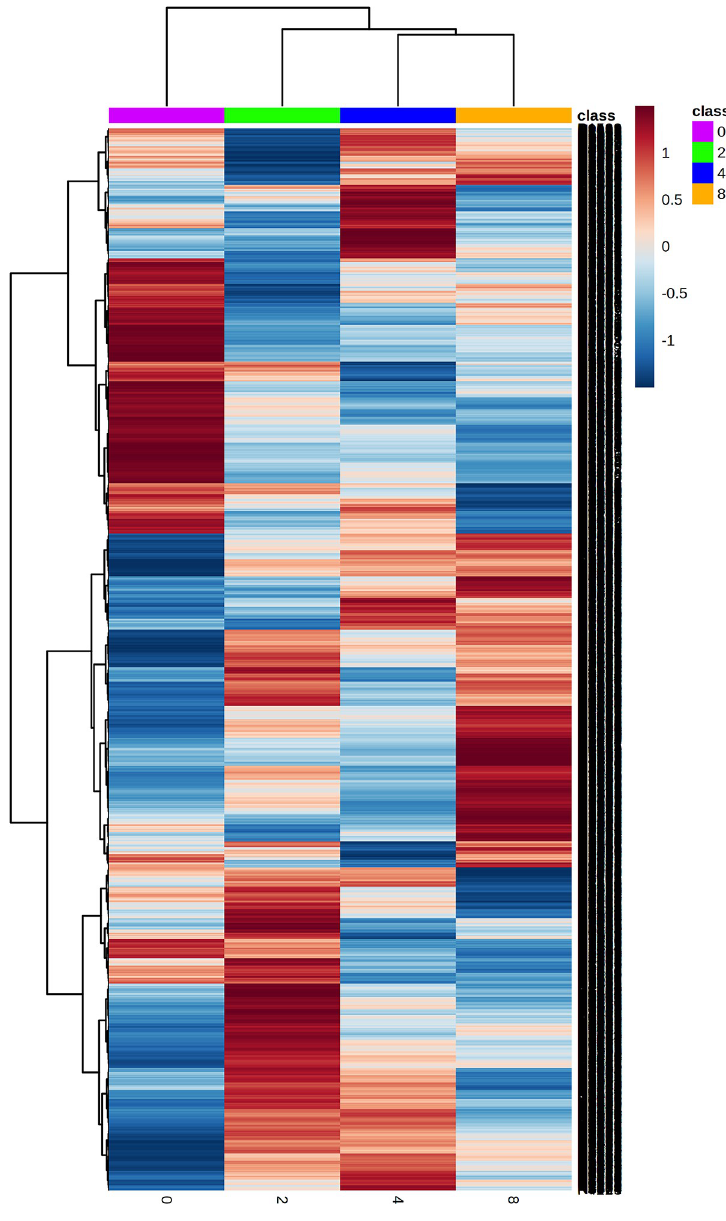
Fig 2. Heatmap analysis of serum metabolites after T . spiralis infection. X-axis represents experimental groups and Y-axis represents metabolite features. Red and blue color indicates higher and lower relative level, respectively. Heatmap shows dissimilar patterns of metabolite features from before infection, and 2-, 4-, and 8-weeks PI.